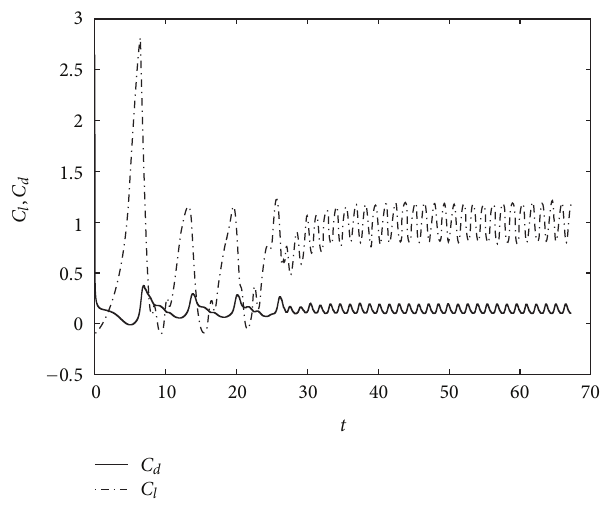
Figure 12: Iced NACA 0012 solution at Re = 1000, evolution of the lift and drag coe ffi cient.